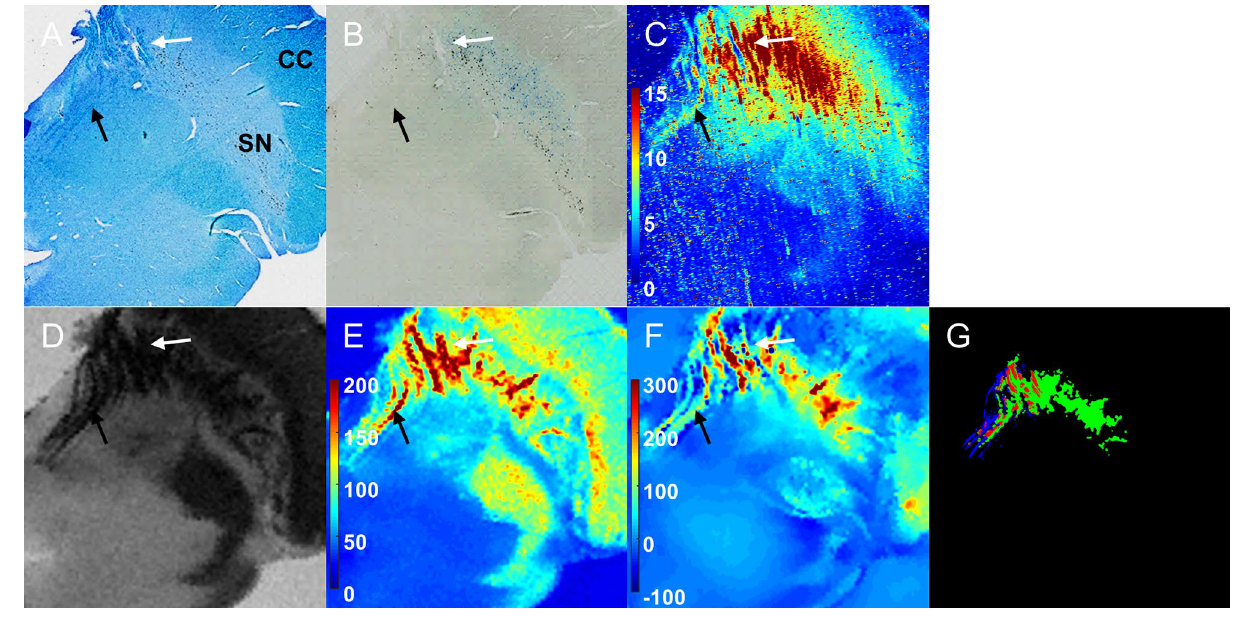
Figure 2. Histopathology and LA-ICP-MS with multimodal MRI on the postmortem SN of a 67-year-old male with PSP. ( A ): Luxol fast blue staining; ( B ): Perls’ Prussian blue staining; ( C ): 56 Fe/ 13 C intensity from LA-ICP-MS imaging (a.u.); ( D ): SWI; ( E ): R 2 * map (1/s); ( F ): QSM (ppb). ( G ) The overlap (red) between myelinated fiber (blue) and hypointense SWI area (green). White and black arrows indicate myelinated fibers at anterior SN and oculomotor nerve. CC = crus cerebri; LA-ICP-MS = laser ablation-inductively coupled plasma-mass spectrometry; PSP = progressive supranuclear palsy; QSM = quantitative susceptibility mapping; SN = substantia nigra; SWI = susceptibility-weighted imaging. Figures were generated from MATLAB (version R2016a, MathWorks, Natick, MA,